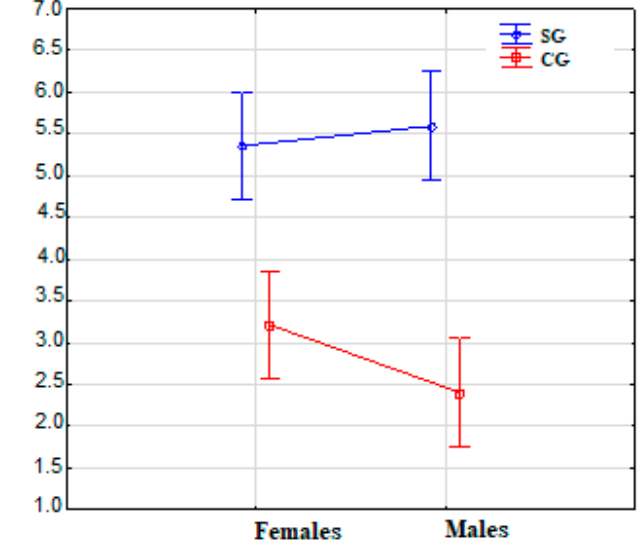
Figure 1. Distribution of the total of CVD risk factors. Note: CVD—cardiovascular disease; CG—control group; SG—post-ischemic stroke group.